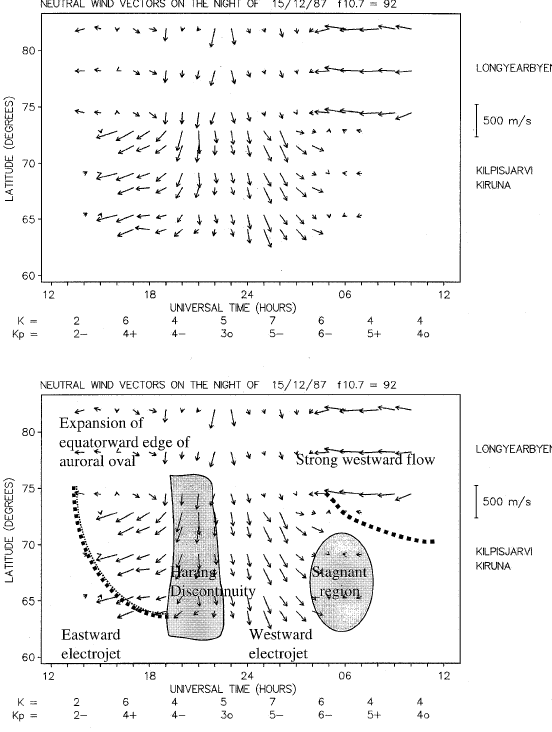
Fig. 5. (a) Neutral winds observed on the night of 15–16 December 1987 with FPIs at Kiruna, Kilpisjarvi and Longyearbyen. (b) Labelled regions common to both the ion and neutral flows are superposed on the neutral winds for comparison with Fig.